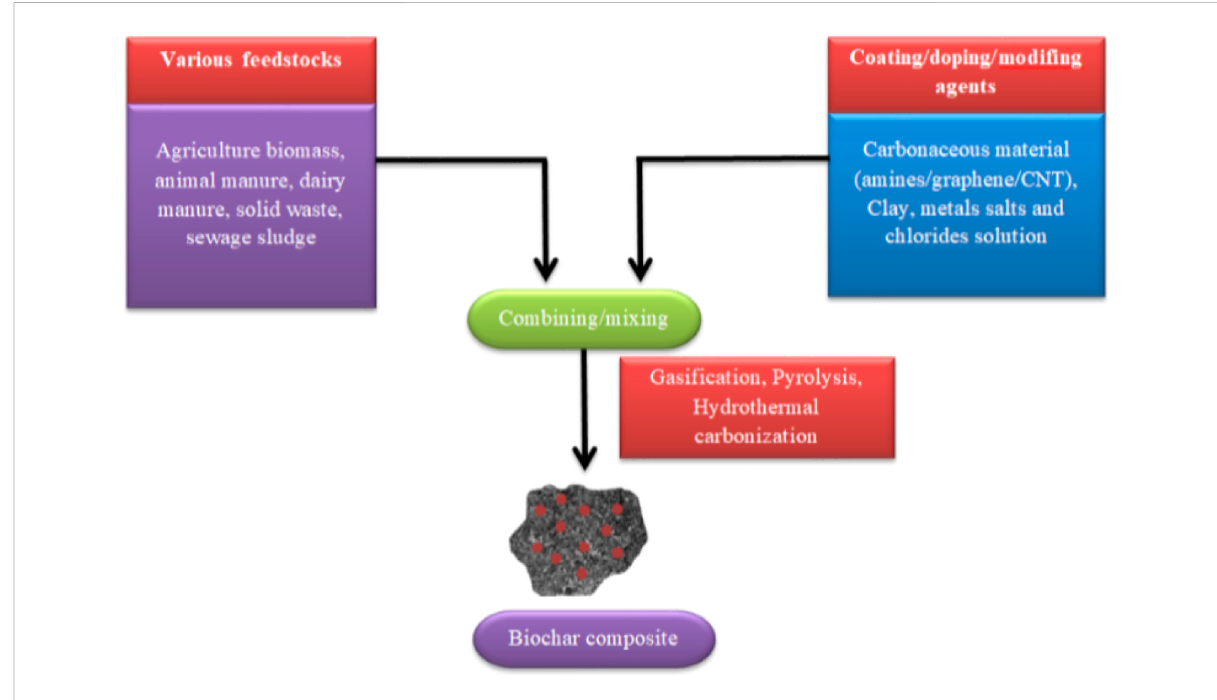
FIGURE 2 Engineered/modi fi ed composite synthesis